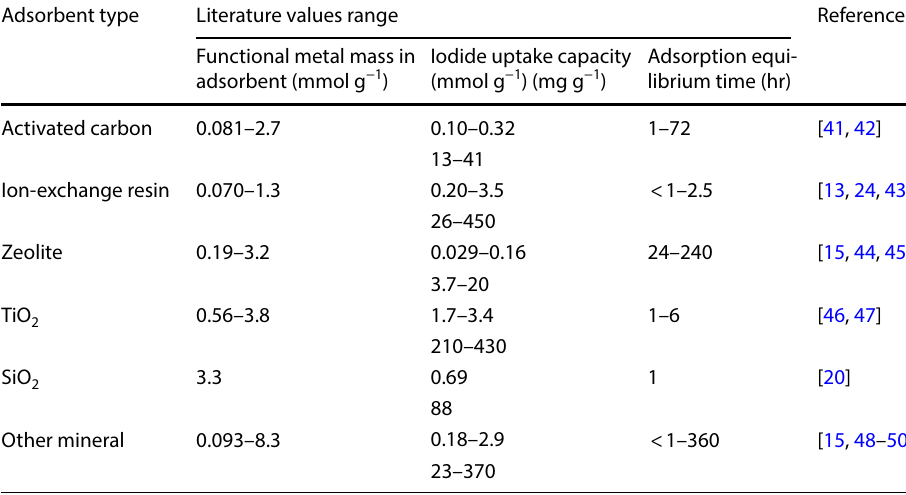
Table 3 Condensed summary of adsorption capabilities of adsorbents